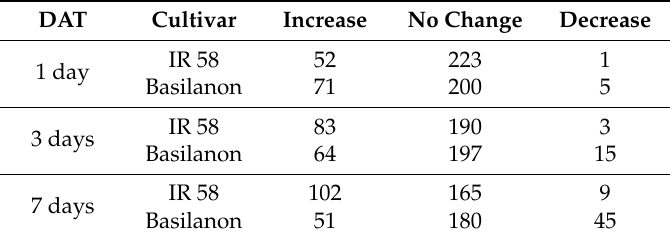
Table 2. Varietal di ff erences in the time course of increases and decreases in metabolites in roots under osmotic stress.